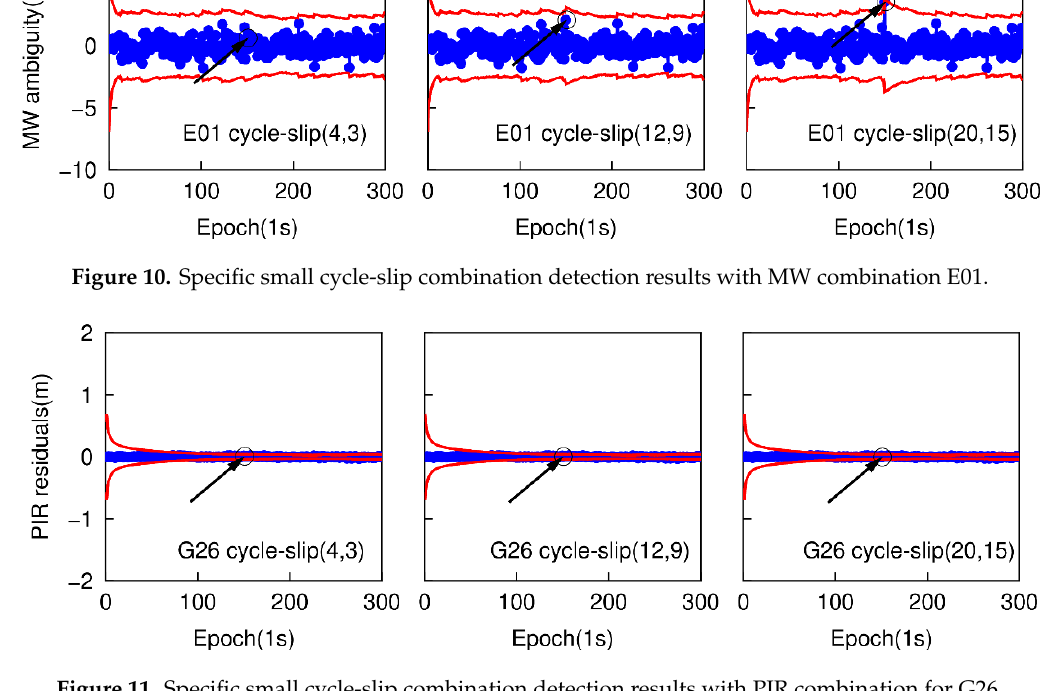
Figure 12. Specific small cycle-slip combination detection results with PIR combination for E01. The epoch-differenced wide-lane combinations, formed by GPS L1/ L5 and Galileo E1/E5a phase observations, are utilized to estimate the changes of smartphone positions and clock bias by applying the least-square adjustment. Figures 13 and 14 show the time series of the residuals of G26 and E01. The over-limit residuals are 0.639, 2.122, 3.535 m for G26 and 0.742, 2.187, 3.227 m for E01 at the 151th epoch. That is to say, the simulated specific small cycle-slip combinations (4, 3), (12, 9), (20, 15) can be clearly detected by checking the largest normalized residual of exceeding the predefined threshold. Figure 13. Specific small cycle-slip combination detection results by checking the largest residual for G26.